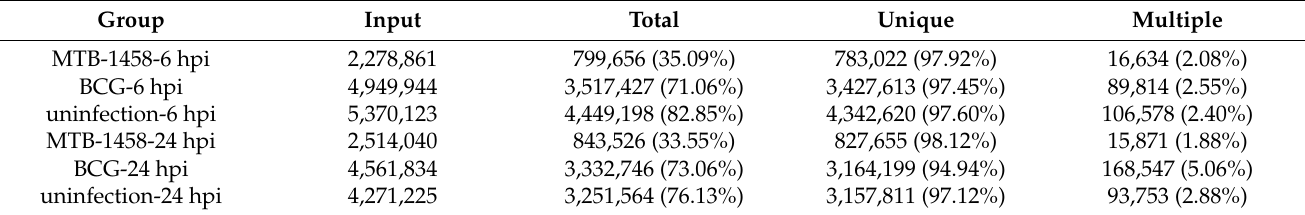
Table 1. Clean reads mapping against human mature miRNAs of